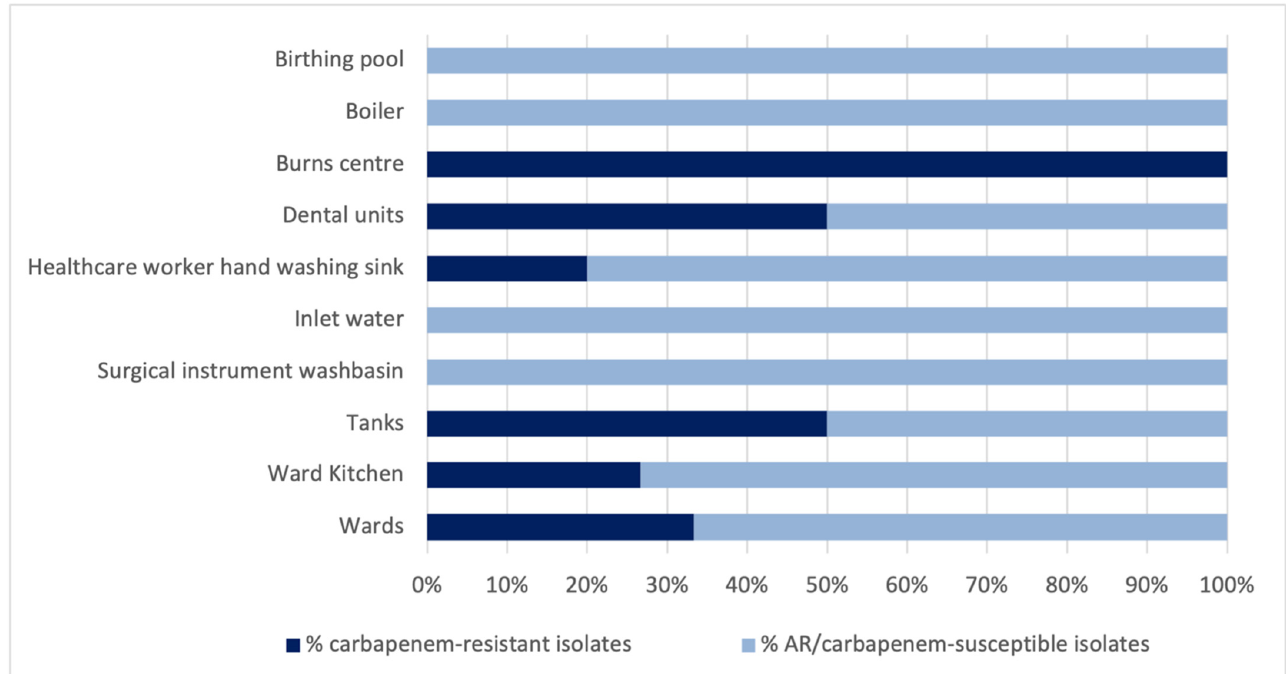
Figure 4. Percentage distribution of carbapenem-resistant P. aeruginosa isolates in the various sampling points. In the dental units, ten P. aeruginosa isolates showed resistance to carbapenems. The difference between the number of carbapenem-resistant isolates in the dental units and those found at the other sampling points was borderline significant (Pearson chi2 = 3.6837; p = 0.053).